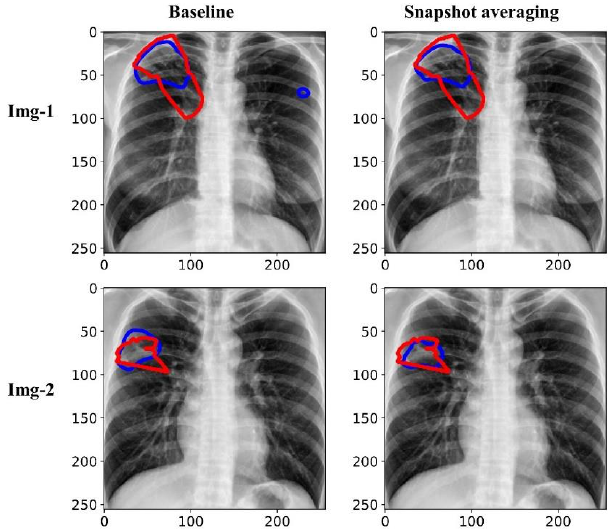
Figure 7. Visualizing and comparing the segmentation predictions of the baseline (i.e., Inception-V3 UNet model trained with lung-cropped CXRs/masks at the 256 × 256 resolution), and the snapshot averaging of the top-5 model snapshots. The red and blue contours denote ground truth and predictions, respectively.